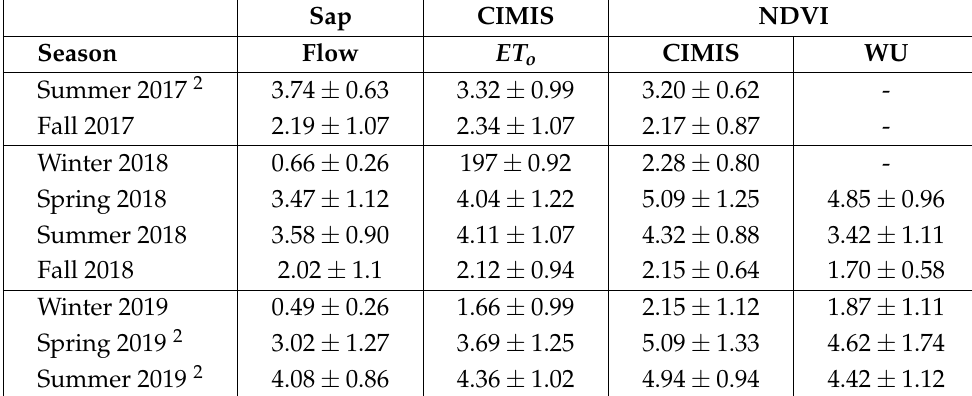
Table 4. Estimates of seasonal mean ET (mm/d) and corresponding MSE from the different methods across the entire riparian forest over study